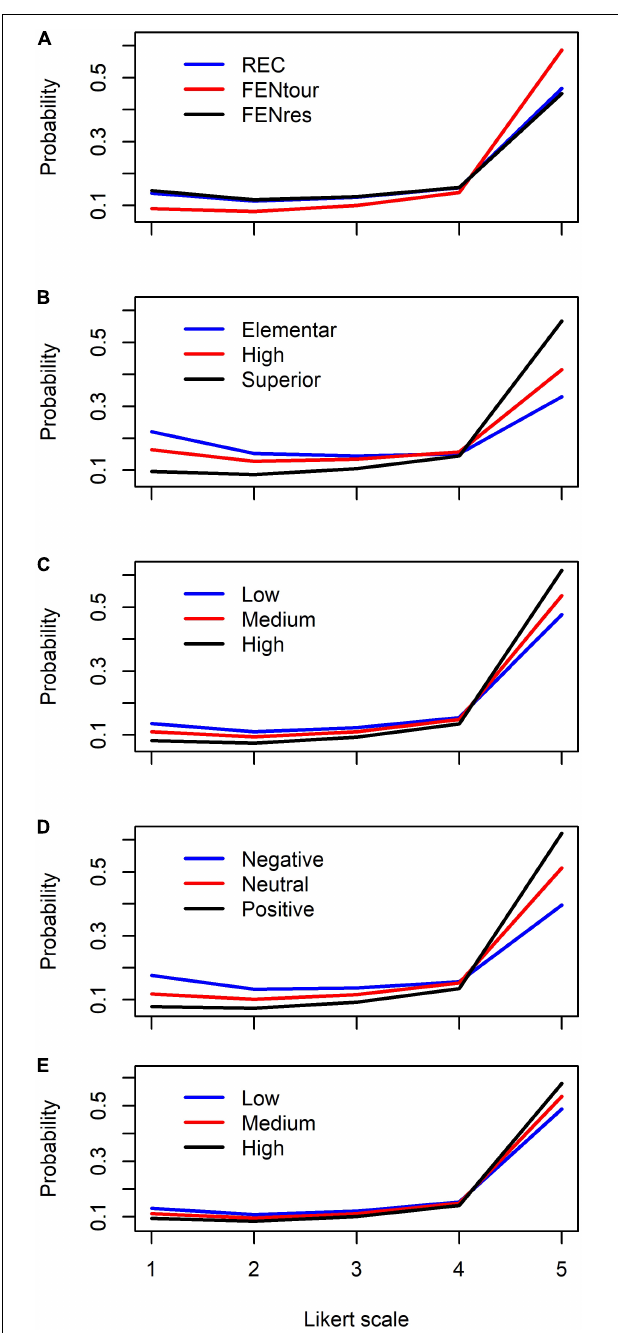
FIGURE 3 | Probability distribution of a 5-level Likert scale of perceptions toward sharks across (A) sampling treatments (i.e., Recife – REC, tourists of Fernando de Noronha – FENtour, and residents at Fernando de Noronha – FENres), (B) education level (i.e., elementary, high, and superior education), (C) affinity for nature classes (i.e., low, medium, and high affinity for nature), (D) types of prejudice toward sharks (i.e., negative, neutral, and positive prejudice), and (E) classes of specific knowledge about sharks (i.e., low, medium, and high specific knowledge), assessed with a Likert-based ordered logistic regression model. The Likert scale spans from 1 through 5, with 5 being the most positive/correct option. Confidence intervals were not included for clarity